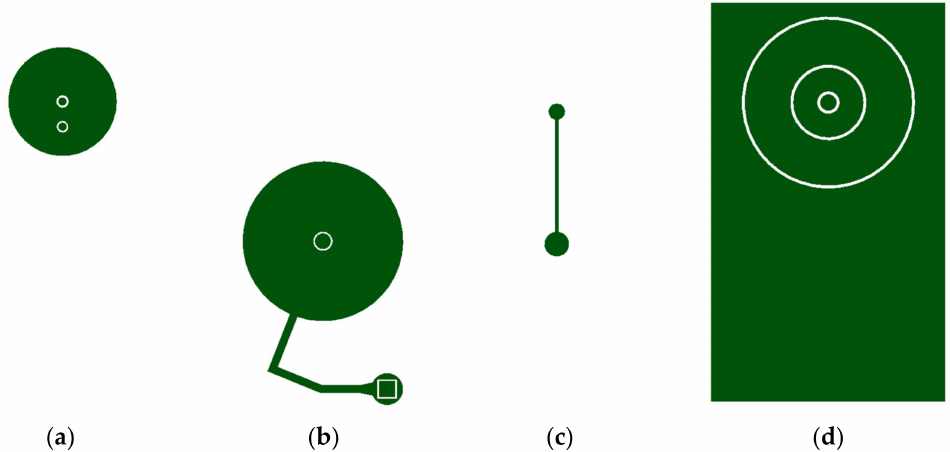
Figure 2. Polyvinyl chloride (PVC) stencils used in the fabrication process. ( a ) Stencil for the secondary chamber. The smaller circles are inlet and outlet for the secondary chamber (inlet = circle away from the center, outlet = circle in the center). ( b ) Stencil for the primary chamber (outlet = Small circle in the center, inlet = rectangle, bolting microchannel = thin fragment). ( c ) Stencil that fabricates the microchannel that connects the secondary and primary chamber. ( d ) Stencil for the magnetically actuated microvalve (outlet of the device = smallest circle, nickel-PDMS stencil = smaller circular band stencil, deflection membrane = larger circular band